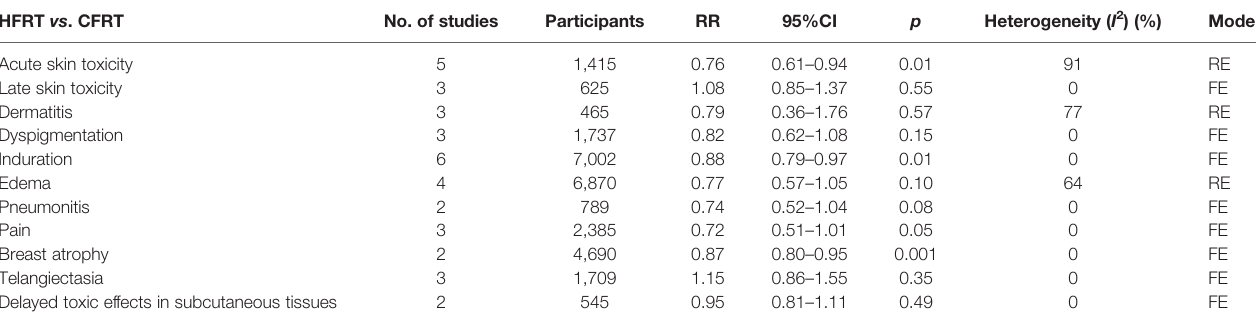
TABLE 2 | All grade adverse events for HFRT vs . CFRT. HFRT vs .